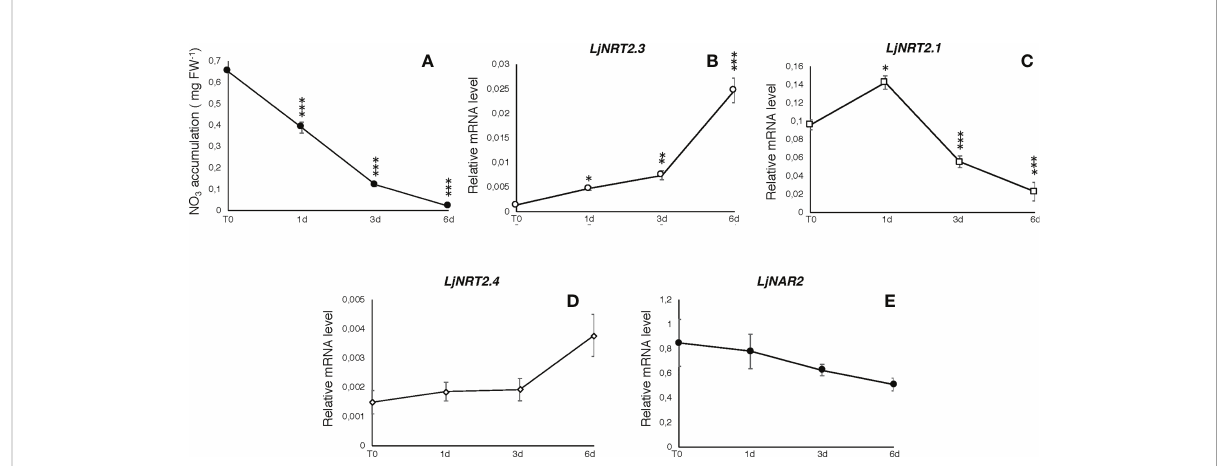
FIGURE 2 Responses to N starvation conditions. Plants were grown for 8 days on B5 derived medium supplemented with 8 mM KNO 3 as sole N source and transferred on N starvation conditions (T0). (A) Measures of nitrate content in Lotus plants during N starvation. Samples were collected at days 0, 1, 3 and 6. Measures are means and SE of three replicates (pooling 4 plants for every time point). Asterisks indicate signi fi cant differences as relative to nitrate content at T0 (*** p<0.0001). (B – E) Pro fi les of expression of LjNRT2 and LjNAR2 genes in response to N starvation. RNA was extracted from roots at T0, 1, 3 and 6 days after the transfer. Expression levels obtained by qRT-PCR were normalized with respect to the internal control ubiquitin ( UBI ) gene. Data represent the mean and standard deviations of results obtained with RNA extracted from three different sets of plants and 3 real-time PCR experiments. Asterisks indicate signi fi cant differences as relative to expression at T0 (*p<0.01; **p<0.001;